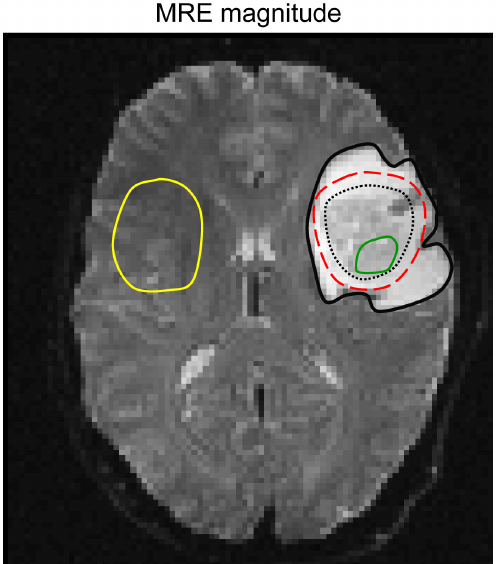
Figure 1. Example illustrating how the regions of interest (ROI) are defined one slice of the MRE magnitude image of patient # 10: healthy tissue (yellow), tumor (black dotted line), perifocal margin (red dashed line), and edema (black solid line). The green line demarcates the region chosen for homogeneous appearing matter